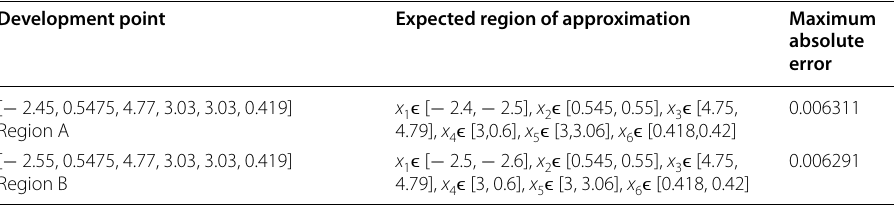
Table 5 Development points and expected region of approximation (yatch hydrodynamics) Development point Expected region of